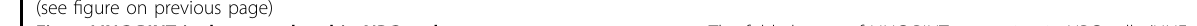
Fig. 1 LINC-PINT is downregulated in NPC and acts as a tumor suppressor. a The fold change of LINC-PINT expression in NPC cells (HNE1, HONE1, CNE1, and CNE2) compared with that in immortalized nasopharyngeal epithelial cell line NP69 by qRT-PCR analysis. b The expression of LINC- PINT in NPC tumor tissues from our data (left) and the GDS3341 dataset (right). c In our data, the area under the ROC curve showing the discriminatory power of the LINC-PINT expression to predict the risk of NPC. d Correlation between LINC-PINT expression and treatment ef fi cacy. CR complete response, PR partial response, SD stable disease, PD progressive disease. e Correlation between LINC-PINT expression and expressions of oncogenes (KRAS, MMP1, MYC, and TP53) in the NPC samples from the GDS3341 dataset. f HNE1 and HONE1 cells overexpressed LINC-PINT and veri fi ed by qRT-PCR. g LINC-PINT overexpression inhibited colony formation in NPC cells. Representative images (left) and quantitative analyses (right) are shown. h LINC-PINT overexpression suppressed cell proliferation in NPC cell lines, which are detected by CCK-8 assay. i Effect of LINC-PINT overexpression on the cell cycle progression. j Hoechst staining (green fl uorescence) was also used to detect the effect of LINC-PINT on changes in apoptosis (up), Scale bar = 100 μ m. Statistical diagrams show signi fi cant differences (bottom). Data represent the mean ± SEM from three independent experiments ( a – j ). Signi fi cance calculated with Student ’ s T test. * P < 0.05, ** P < 0.01, *** P < 0.001. Data shown are mean ±